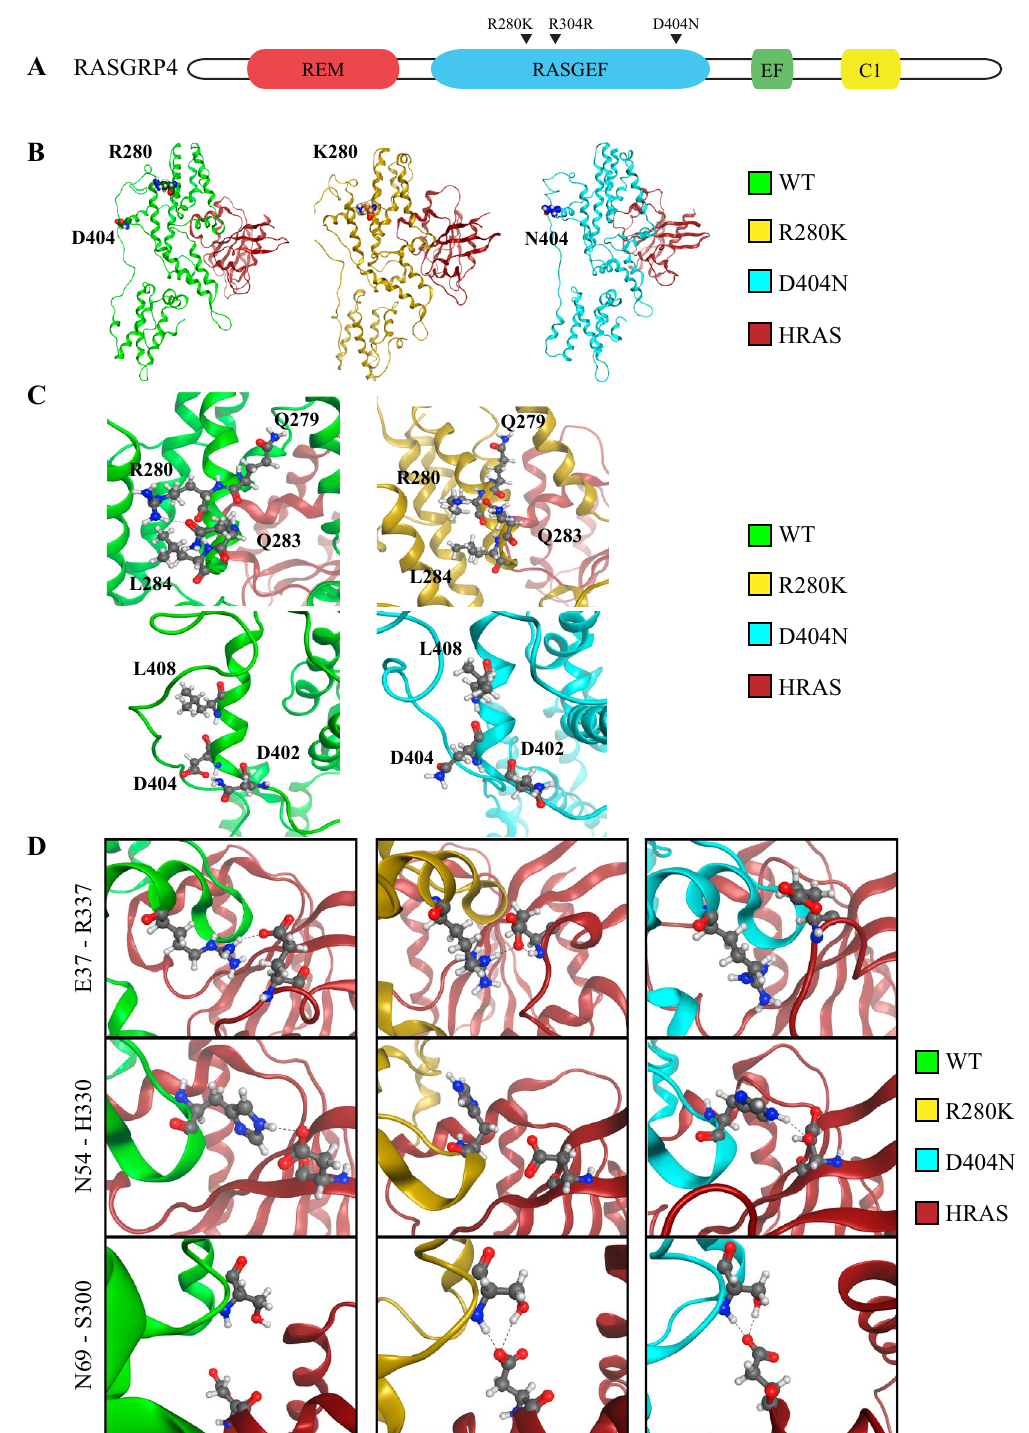
Figure 3. ( A ) Diagram on relevant domains within RASGRP4 with mutations highlighted. ( B ) Graphical representation of the three HRAS-RASGRP4 complexes predicted after applying molecular docking and molecular dynamics simulations. Mutations under study are highlighted. ( C ) Comparison of the intramolecular H-bond pattern established with the wild-type protein (left) and D404N and R280K mutated amino acids (right). ( D ) Changes on the intermolecular H-bond pattern between HRAS and RASGRP4 that could explain the different stabilities of the complexes. The first residue refers to HRAS and the second to